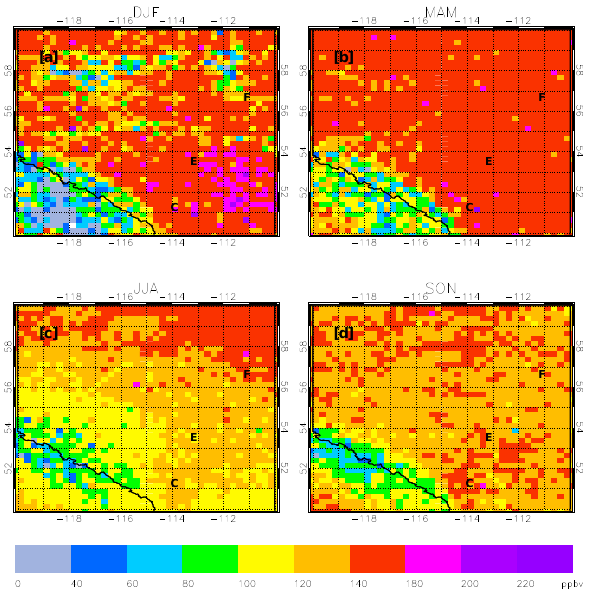
Figure 3. MOPITT daytime CO mixing ratios at the surface level over Alberta for the period March 2002 to December 2013 in (a) winter, (b) spring, (c) summer, and (d) fall. The symbols F, E, and C represent the cities of Fort McMurray, Edmonton, and Cal- gary, respectively. Data are gridded at 0.25 × 0.25 ◦ resolution.